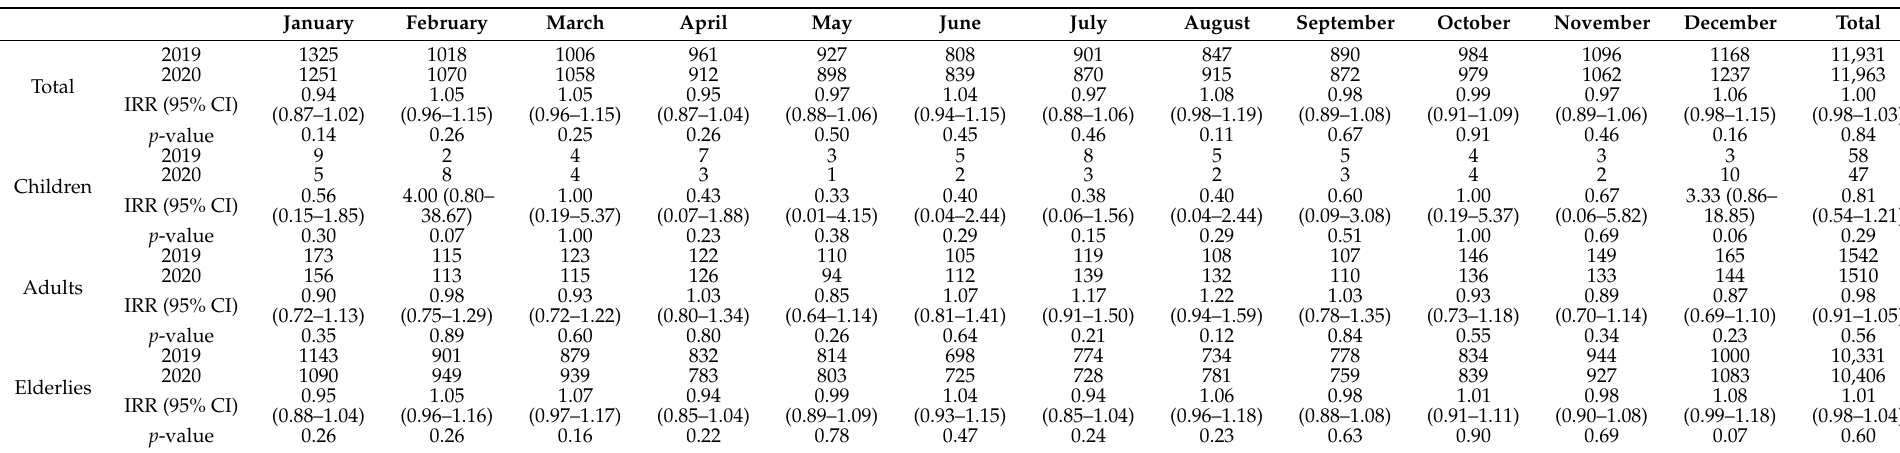
Table 4. The number of deaths among hospitalized emergency patients registered in the Osaka Emergency Information Research Intelligent Operation Network